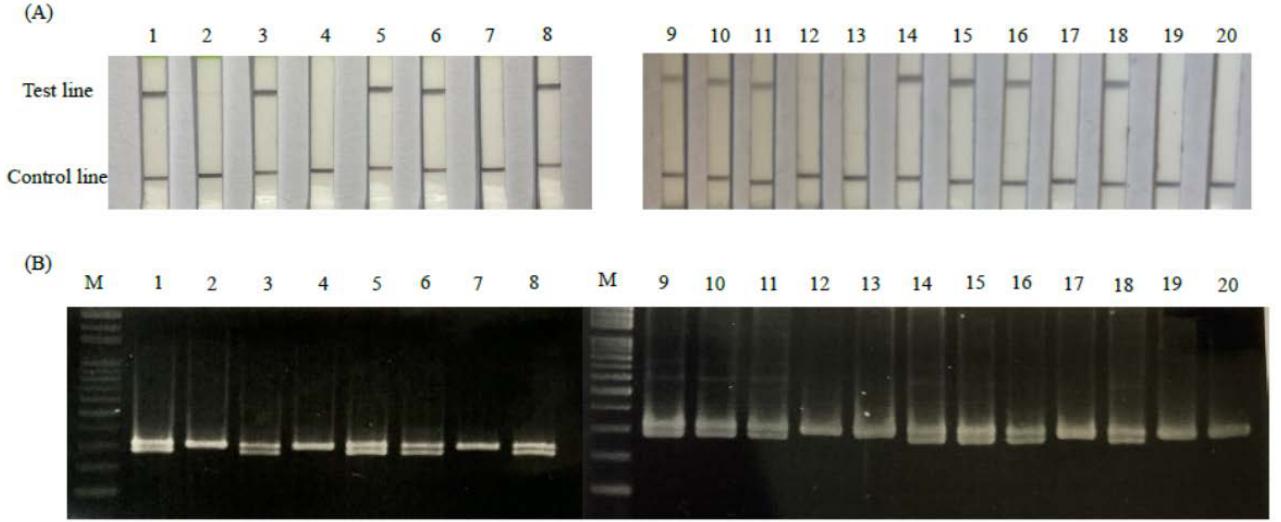
Figure 5. Molecular reliability of the RPA-LFD method for pigeon sex identification. ( A ) The results are visualized by LFD. ( B ) The results for the same samples were visualized by PCR-AGE. Lanes M: 100 bp ladder molecular marker. In addition, 1–20 were 20 random samples selected from samples of 20 pigeons (from different lots).